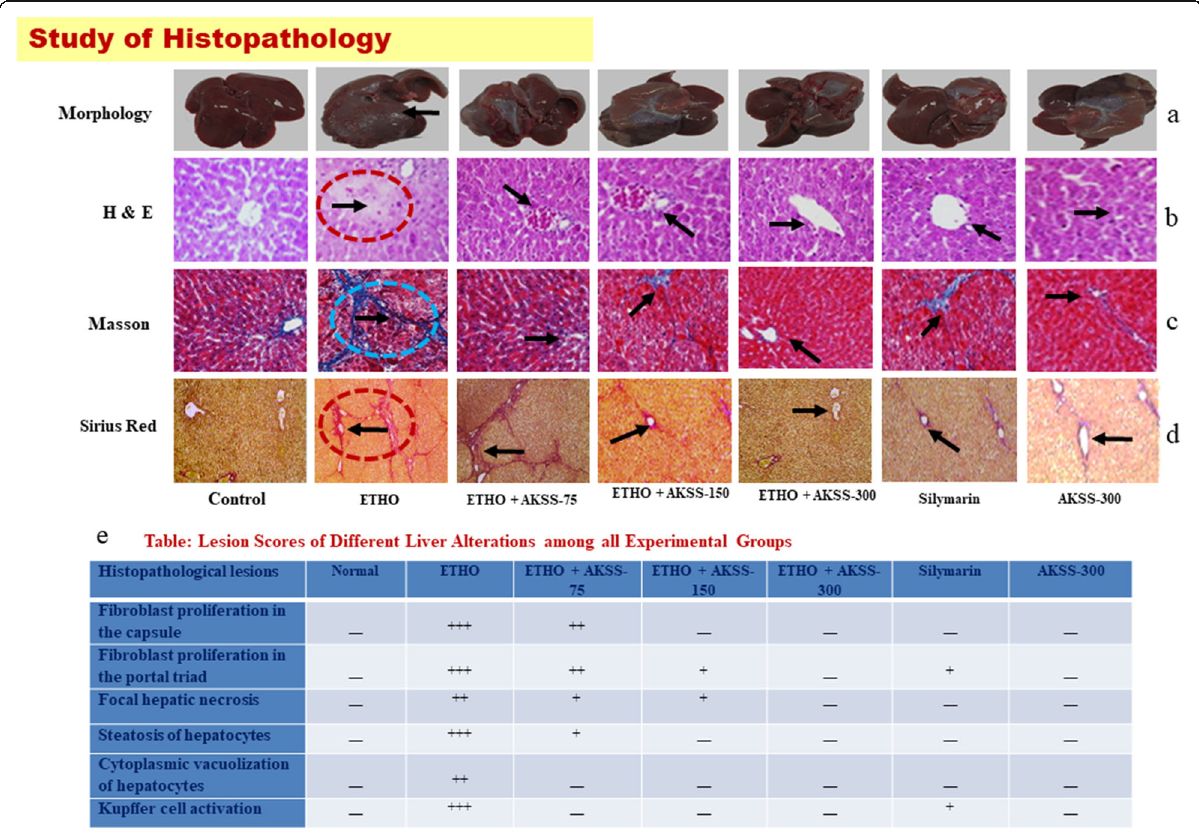
Fig. 5 Representative photomicrographs of livers in different experimental groups. a liver morphology b H & E stained liver sections c Masson trichrom stained liver sections d Sirius red stained liver sections. e Table showed histological scoring of the liver section in different